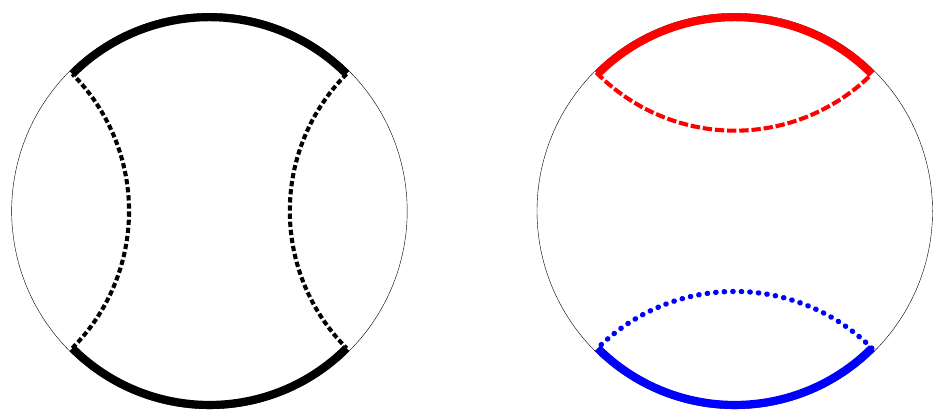
Figure 1 . The connected (left) and disconnected (right) phases of the holographic entanglement entropy of two intervals. The coloring of the disconnected phase is explained in the text; see also (cid:12)gure